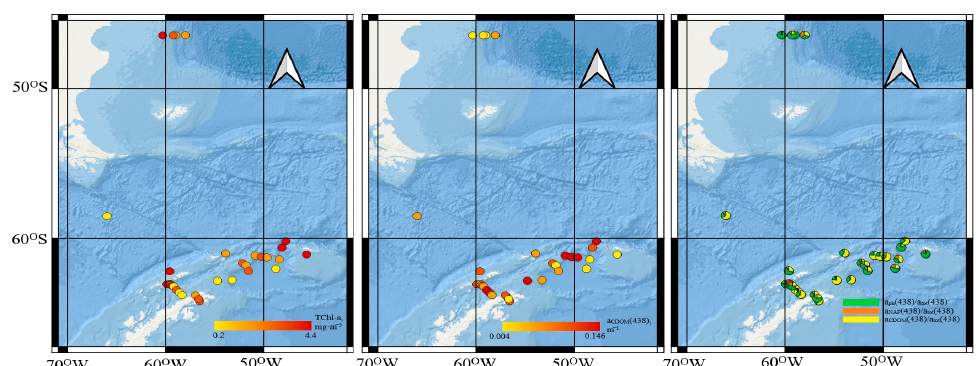
Figure 11. Map of the sum of chlorophyll a and phaeopigment concentration (TChl- a , left panel), light absorption coefficient of colored dissolved organic matter at 438 nm ( a CDOM (438), middle panel), and contribution of the phytoplankton( a ph (438)/ a tot (438)), non-algal particles ( a NAP (438)/ a tot (438)), and CDOM ( a CDOM (438)/ a tot (438)) to total non-water absorption at 438 nm (left panel). The a ph ( λ ) correlated with TChl- a ( a ph (438) = 0.048 × C a1.2 , r 2 = 0.83, N = 126; a ph (678) = 0.022 × C a1.2 , r 2 = 0.92, N = 126). The power coefficients were > 1. This reflects the increasing chlorophyll a -specific phytoplankton absorption coefficients ( a* ph ( λ )), with a rise of